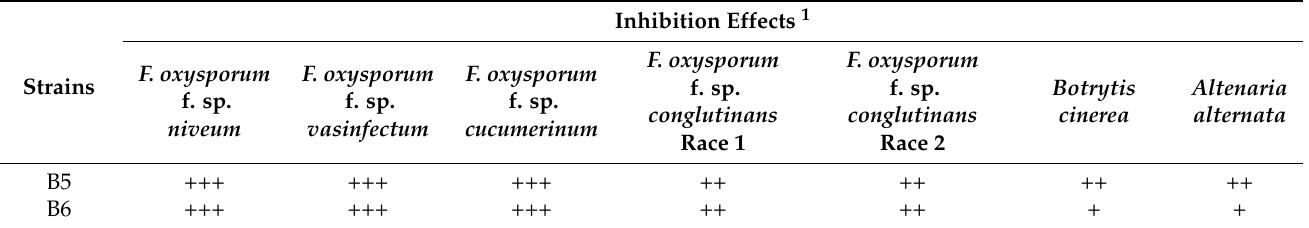
Table 1. Antifungal activity of B5 and B6 against different pathogens in vitro.